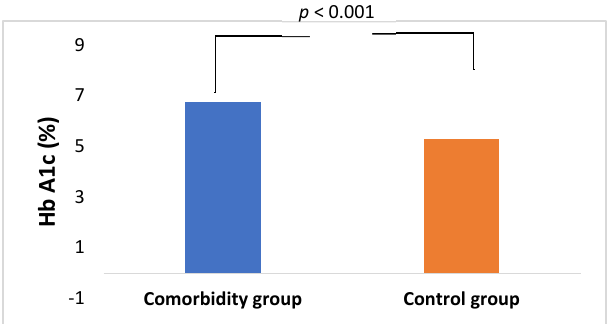
Figure 1. Distribution of diabetes mellitus, hypertension, and hypercholesterolemia in the comorbidity group suffering from Bell’s palsy.